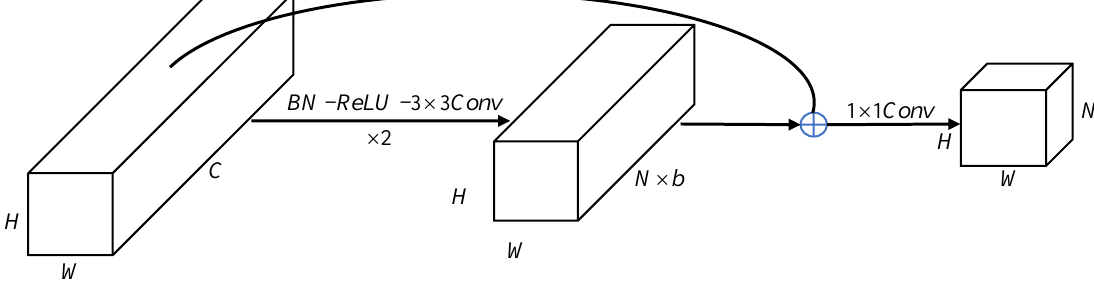
Figure 4. The structure of Channel Ladder Refinement module. ‘ × 2’ denotes ‘ BN - ReLU - 3 × 3 Conv ’ is repeated